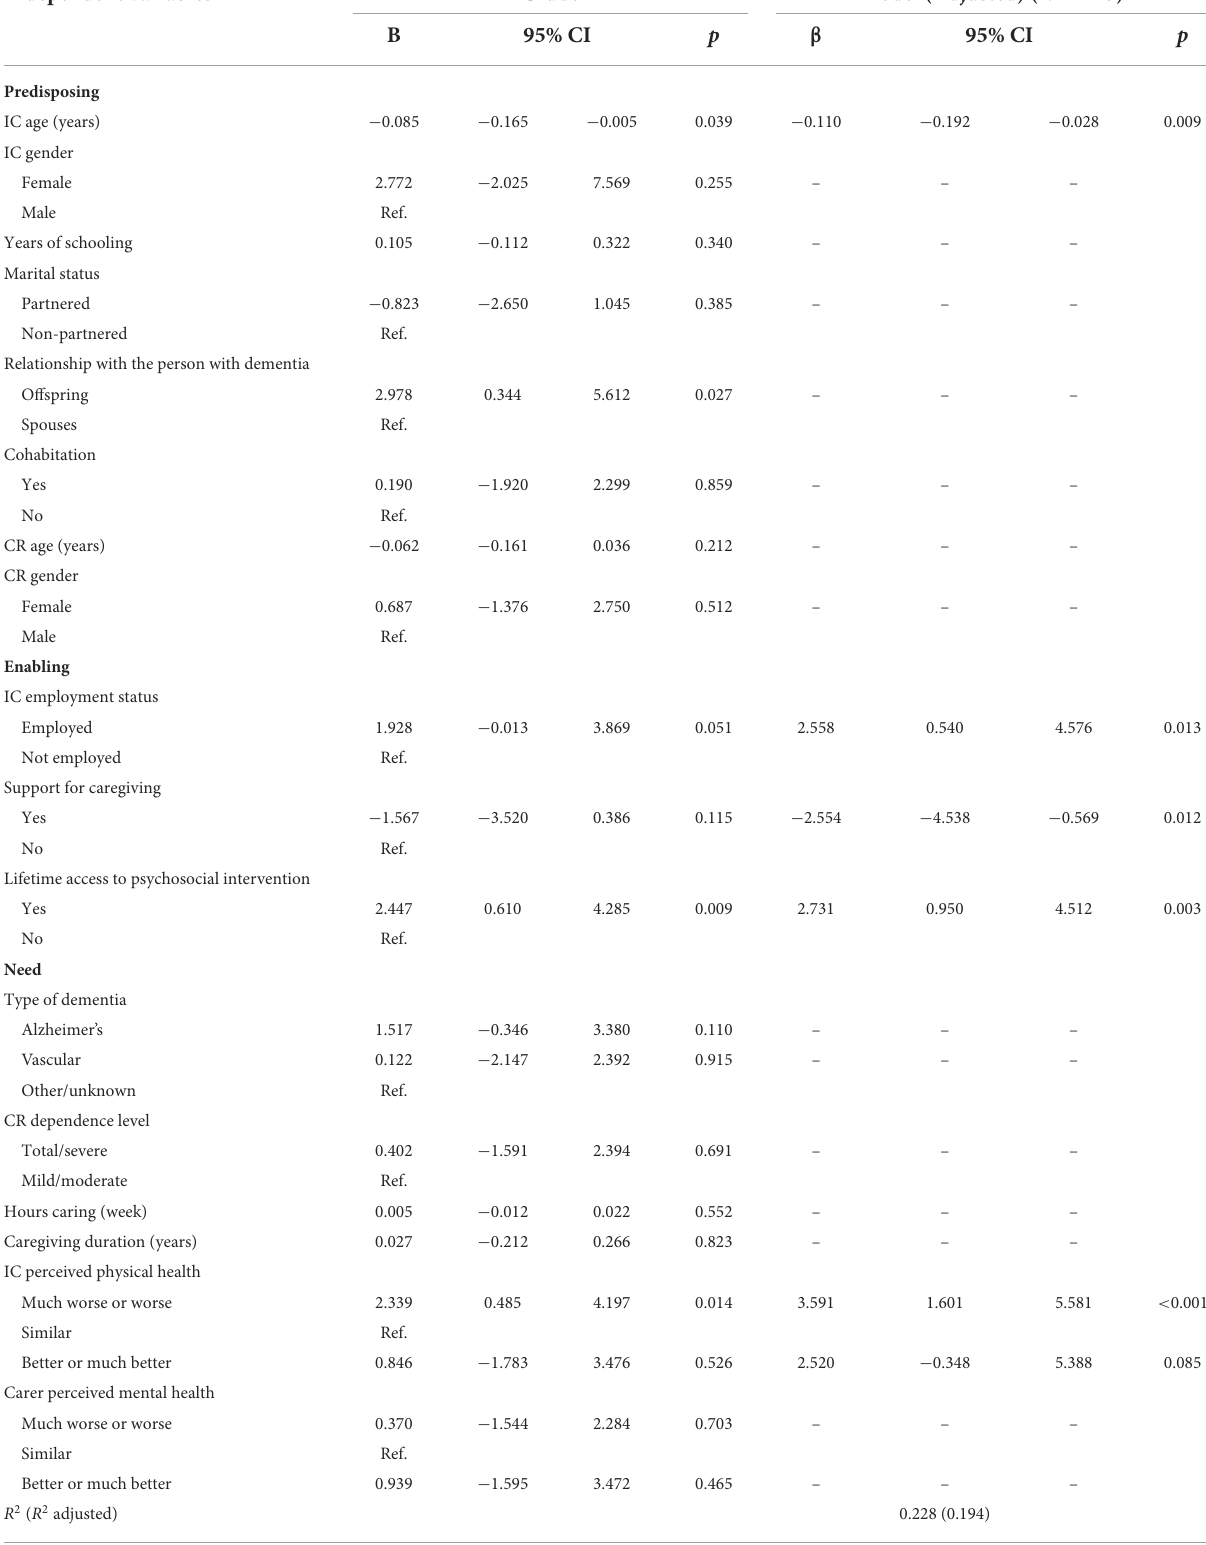
TABLE 5 Univariable and multivariable linear regression models for the association between the frequency of using dementia and caregiving-related internet resources (composite) and predisposing, enabling, and need variables in informal dementia carers. Independent variables